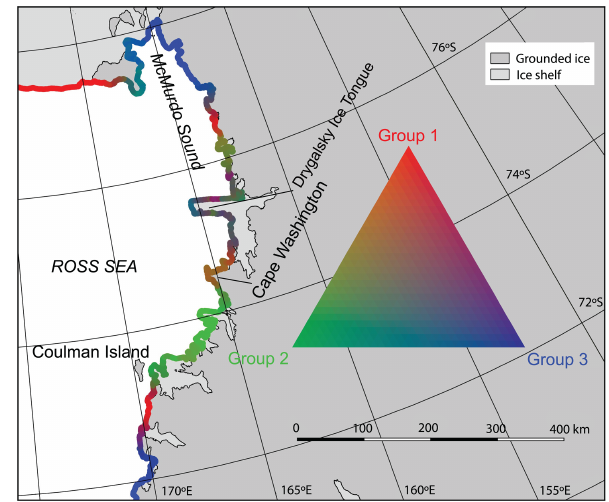
Figure 10. Enlargement of the Lützow–Holm Bay–Enderby Land– Prince Olav Coast region, showing a diversity of complexity classes. The deep (100km across) Lützow–Holm Bay embayment is pre- dominantly group 3, whereas the remainder of the coast is either largely group 1 (smooth stretch of Prince Olav Coast) or a mixture including group 2 (north-eastern Enderby Land). Lützow–Holm Bay is so deeply embayed that it shelters and favours formation of multiyear fast ice, whereas along the Enderby Land coast the much higher degree of exposure permits fast ice to form only seasonally.